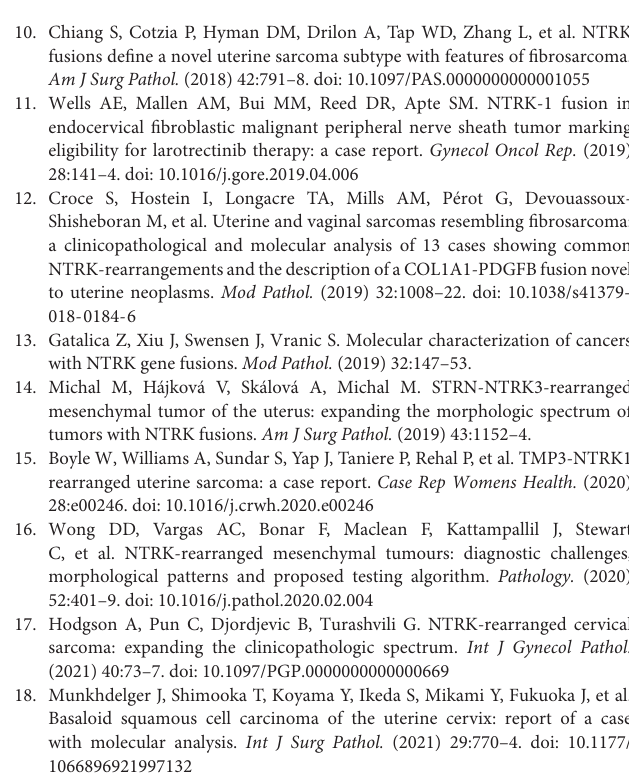
Supplementary Figure 1 | Representative image of the fluorescence in situ hybridization (FISH) assay evaluating the expression of NTRK1 in the tumor tissue (A: 100 × , B: 400 × ): the NTRK1 rearrangement was shown by a paired red (centromeric)–green (telomeric) fluorescence signal, NTRK1 gene signal was mostly 1-3FU, but only approximately 11% of cells were 0R-1GR-1FU in this case, which did not support the existence of NTRK1 rearrangement in the tumor. Supplementary Figure 2 | Images of H&E-stained (100 × and 400 × ) of the endometrial polyp. Supplementary Figure 3 | Image of the chest computed tomography (CT) showing multiple nodules in both lungs, and the largest one was 1.9 × 2.4 cm (red arrowhead on the right). Supplementary Figure 4 | Flowchart for the